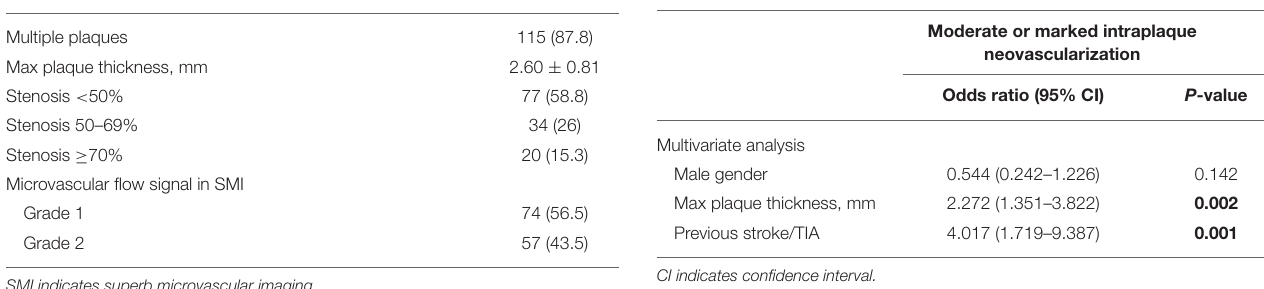
TABLE 4 | Multivariate analysis for patients with moderate or marked intraplaque